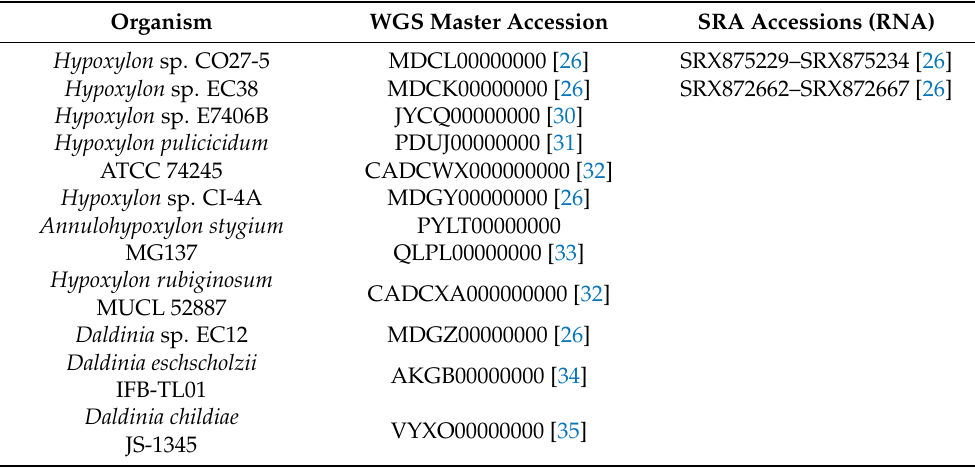
Table 1. Genome and SRA resources employed in this